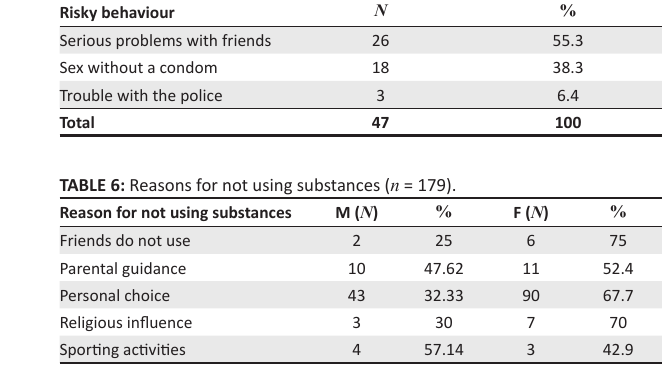
TABLE 5: Associated risky behaviours.